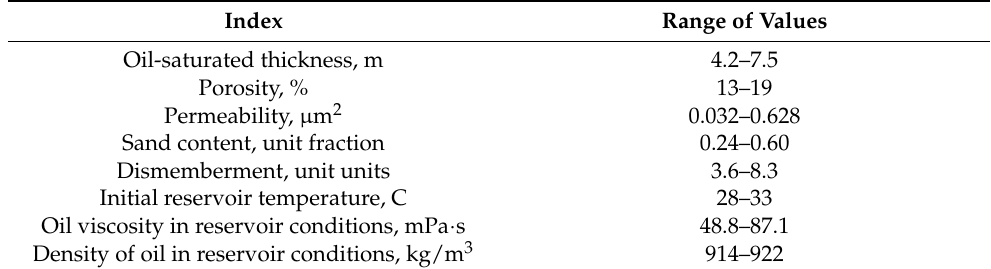
Table 6. Water migration time from the injection well to the production well. №